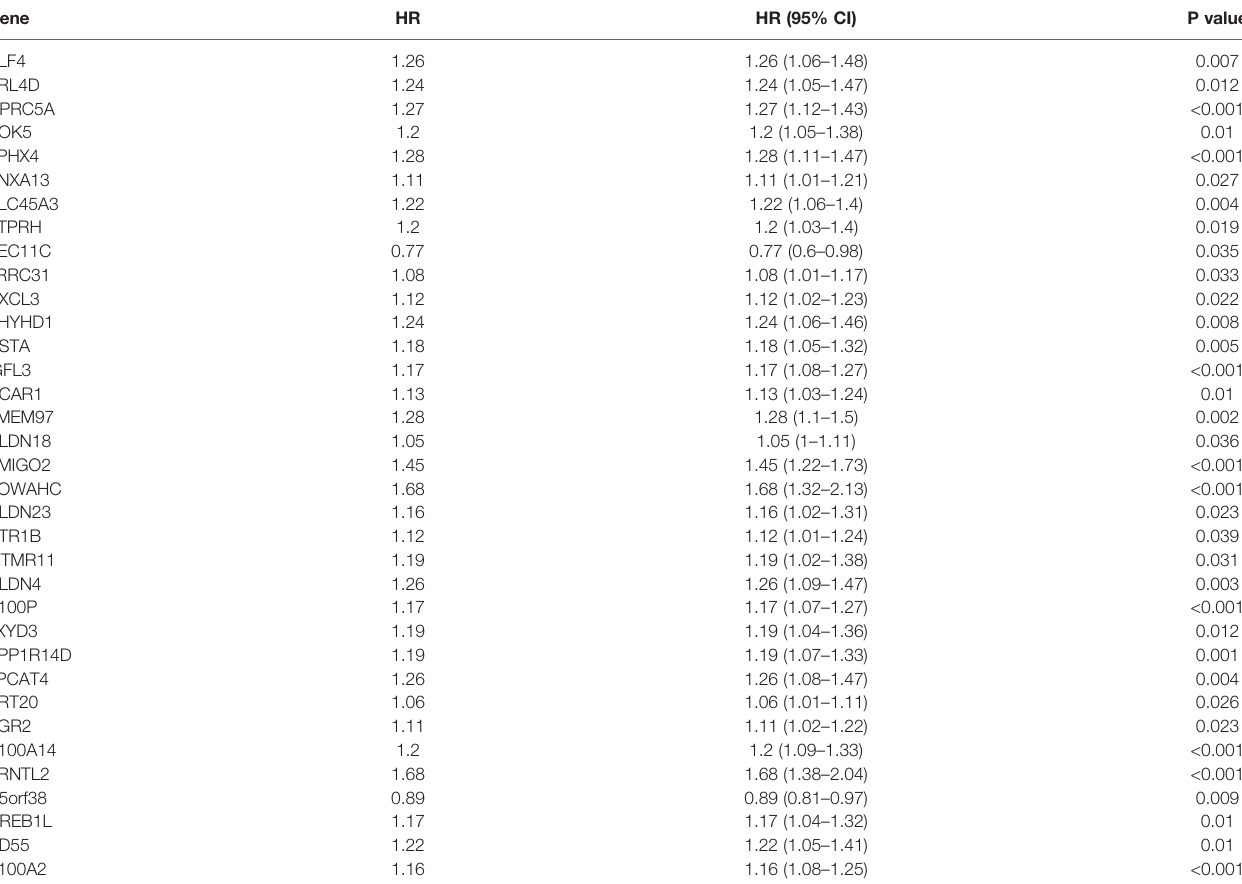
TABLE 1 | Univariate Cox regression analysis results of the 35 MDGs. Gene HR P value